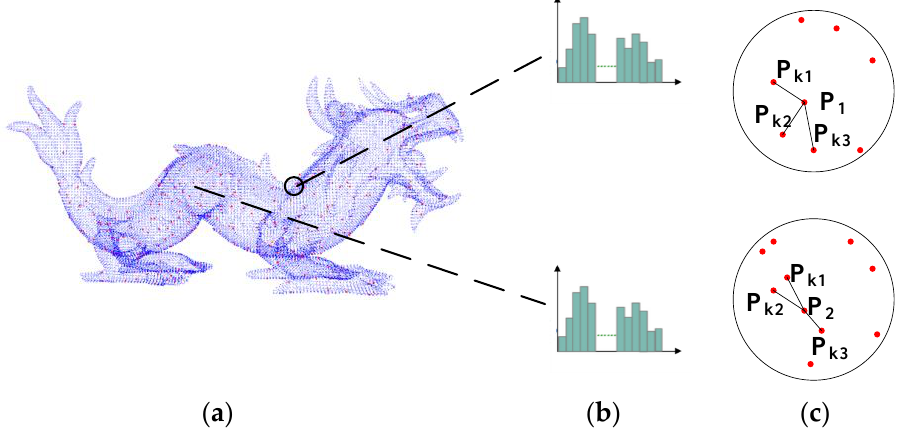
Figure 3. Geometric relationship between local surface similar keypoints and their adjacent keypoints ( a ) the model “dragon” ( b ) local surface features ( c ) keypoints features.